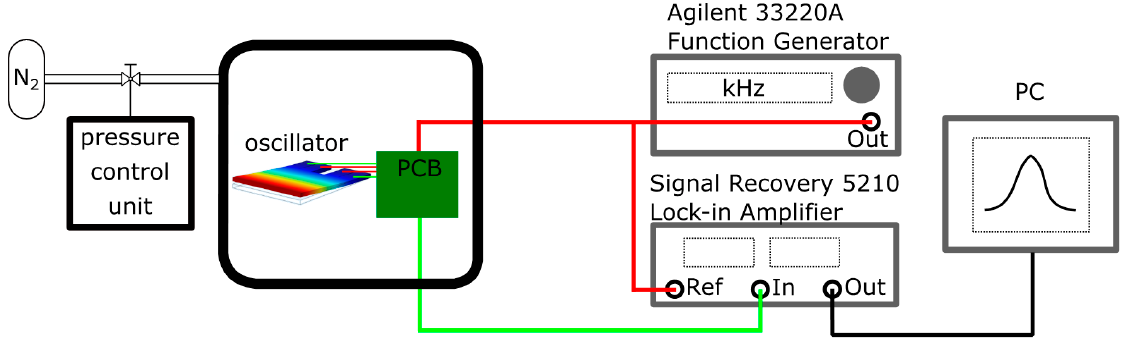
Figure 5. Schematic of the experimental setup. The vacuum chamber ranges from 10 − 3 to 10 3 mbar.